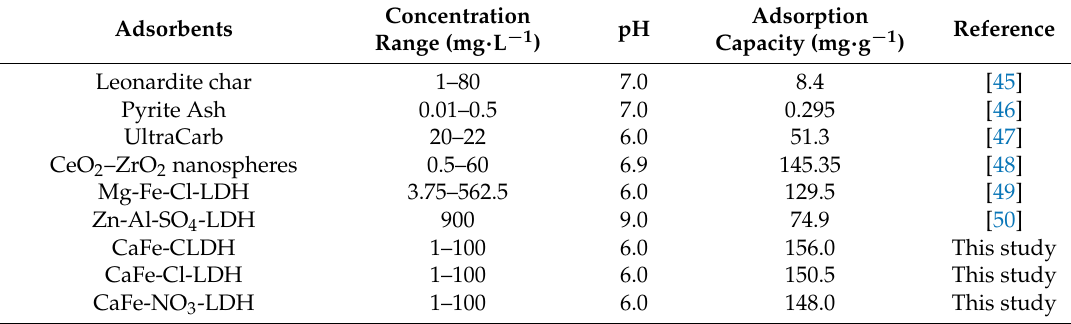
Table 3. Comparison of adsorption capacity for arsenate onto CaFe-LDHs with other reported